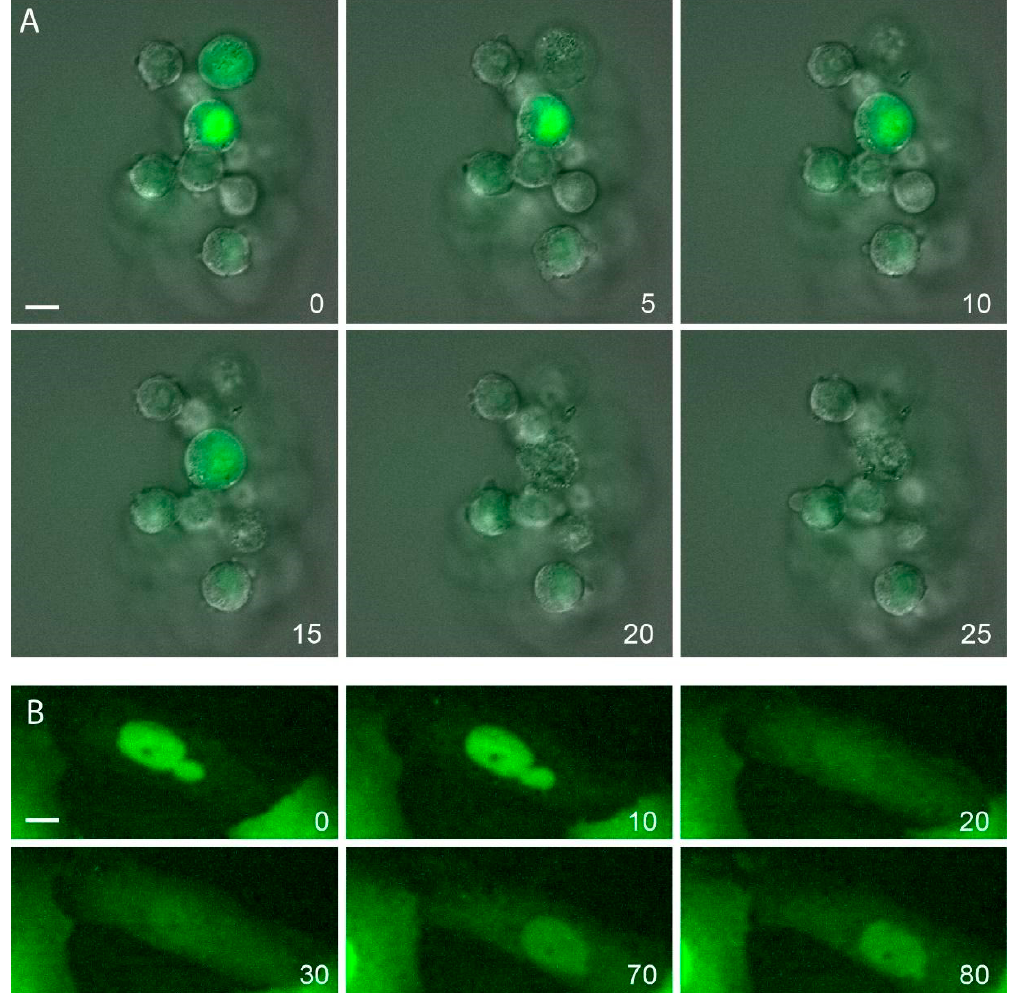
Figure 4. Time lapse recordings of nuclear ruptures in cancer cell lines, transfected with YFP-tagged NLS protein. ( A ) Small cell lung cancer cell line NL-SCLC3. Note that nuclear rupture at 10 min of recording leads to cell shrinkage and cell death (visible at 20 min, likely via apoptosis). ( B ) Skin cancer cell line MCC26, transfected with YFP-NLS. Note nuclear rupture around 20 min, with partial restoration of nuclear signal and without induction of cell death. Bars represent 10 µm.